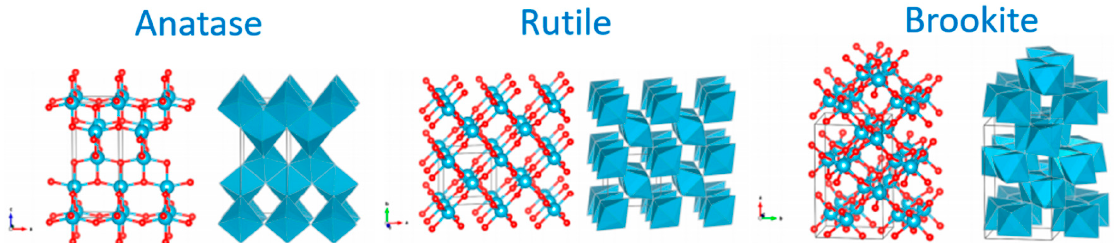
Figure 3. Unit cells of TiO 2 rutile, anatase and brookite [125]. Reprinted with permission from Structural Characteristics and Mechanical and Thermodynamic Properties of Nanocrystalline TiO 2 , Chemical Reviews, 2014, 114, 19, 9613–9644. Copyright 2021 American Chemical Society.